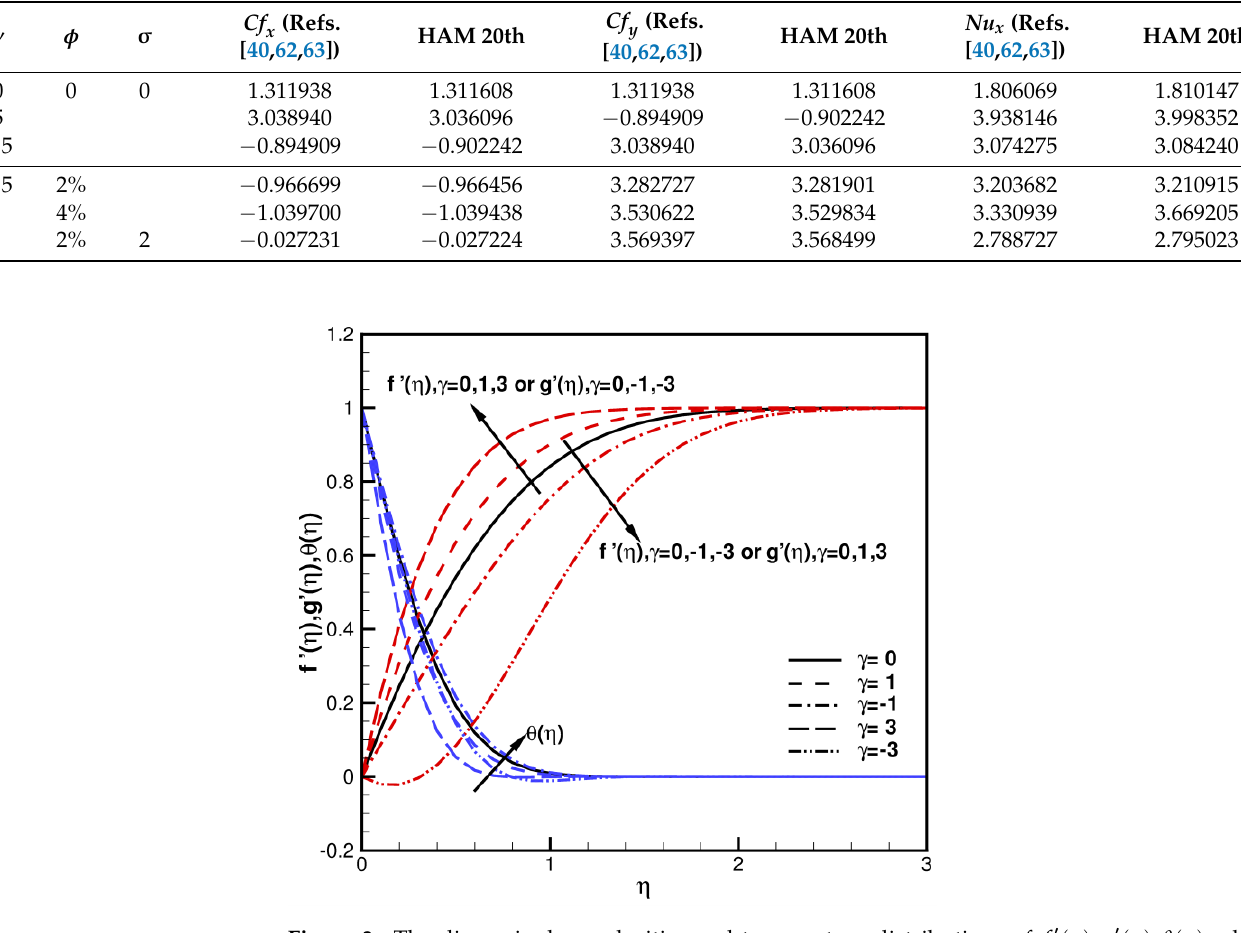
Figure 3. The dimensionless velocities and temperature distributions of f (cid:48) ( η ) , g (cid:48) ( η ) , θ ( η ) when φ = φ 1 = φ 2 = 0, σ = 0, and Pr = 6.2.